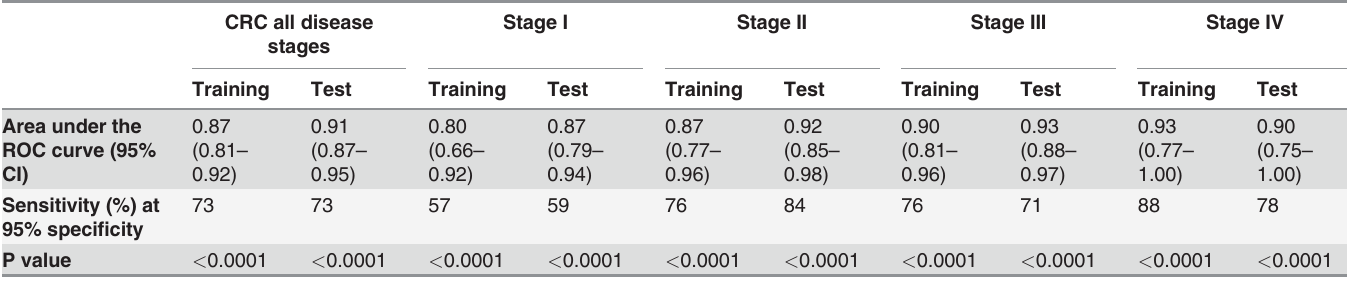
Table 4. Performance characteristics of the three-biomarker model (DKK3, IGFBP2 and